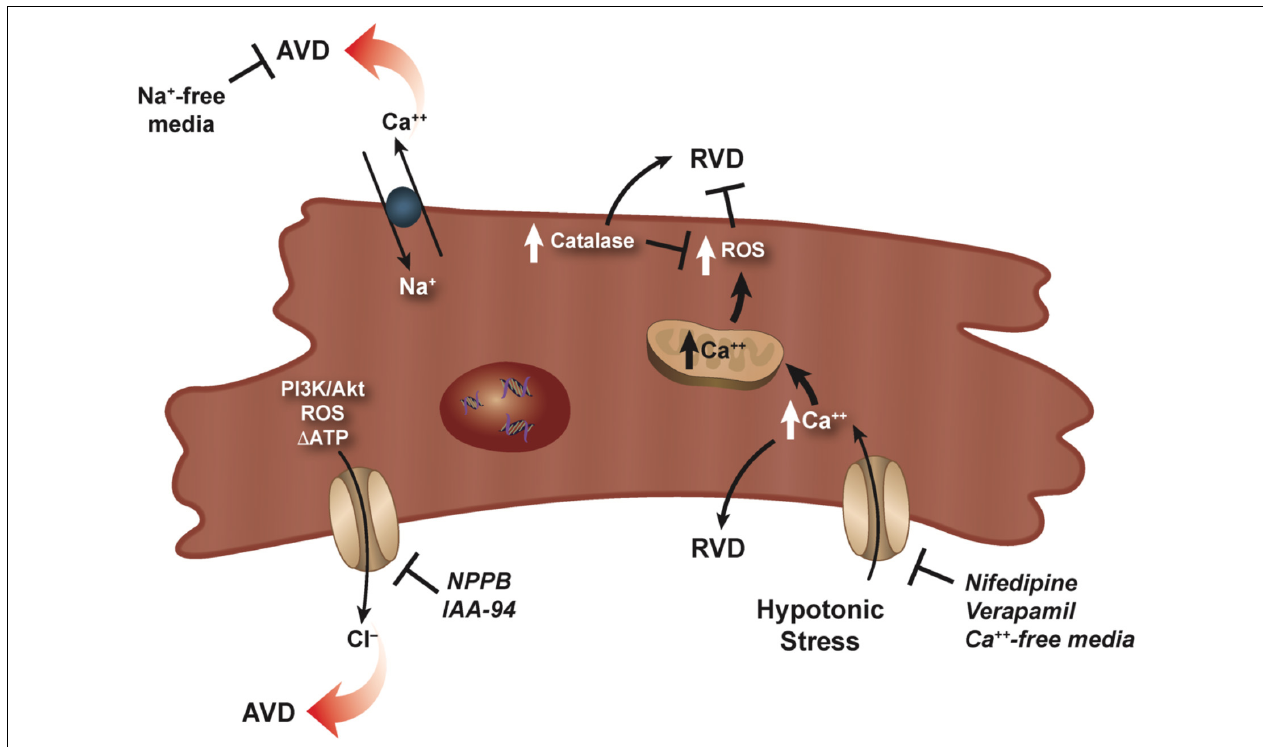
FIGURE 2 | RVD and AVD in cardiomyocytes. Dual role of calcium for RVD in cardiomyocytes is illustrated as a hypotonic-induced increase in intracellular calcium activates RVD. However, a simultaneous increase in ROS masks and/or prevents RVD. RVD can be restored via overexpression of catalase which lowers the ROS concentration. Activation of volume-sensitive chloride channels via kinases, ROS, and/or changes in the level of ATP were shown to have a major effect on cardiomyocyte AVD, which can be prevented upon addition of specific chloride channel blockers. Additionally, reverse mode of the Na–Ca exchanger can also result in AVD as sodium-free conditions prevents this loss of cell